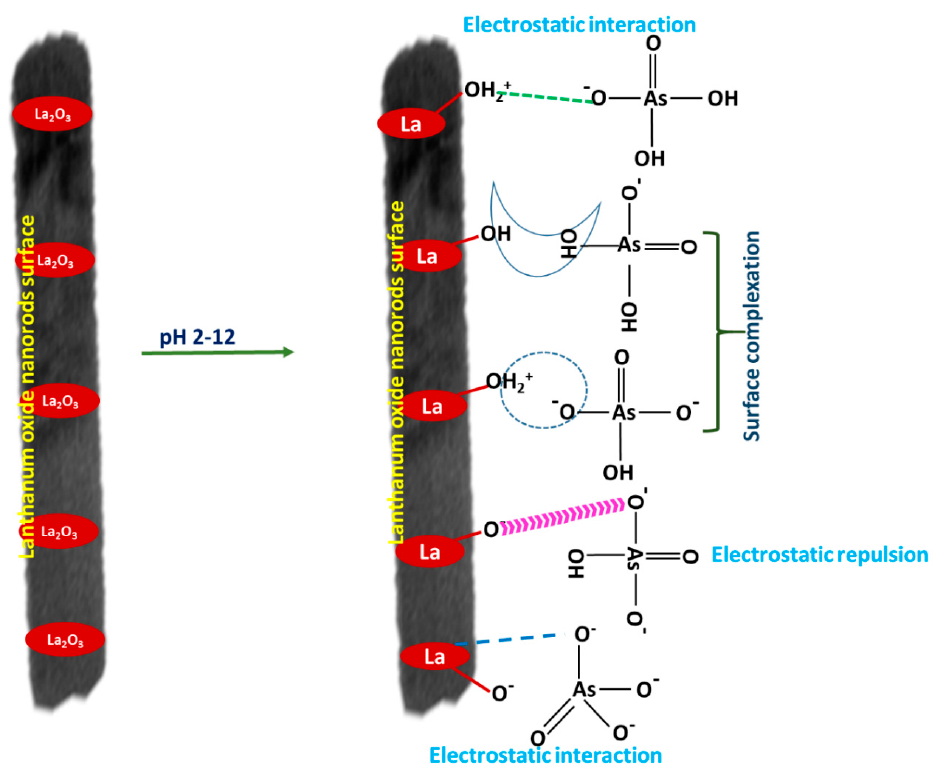
Metals 2020 , 10 , x FOR PEER REVIEW Figure 6. Adsorption mechanism of As(V) on La 2 O 3 nanorods at pH range 3.0 – 12.0. Figure 6. Adsorption mechanism of As(V) on La 2 O 3 nanorods at pH range 3.0–12.0.